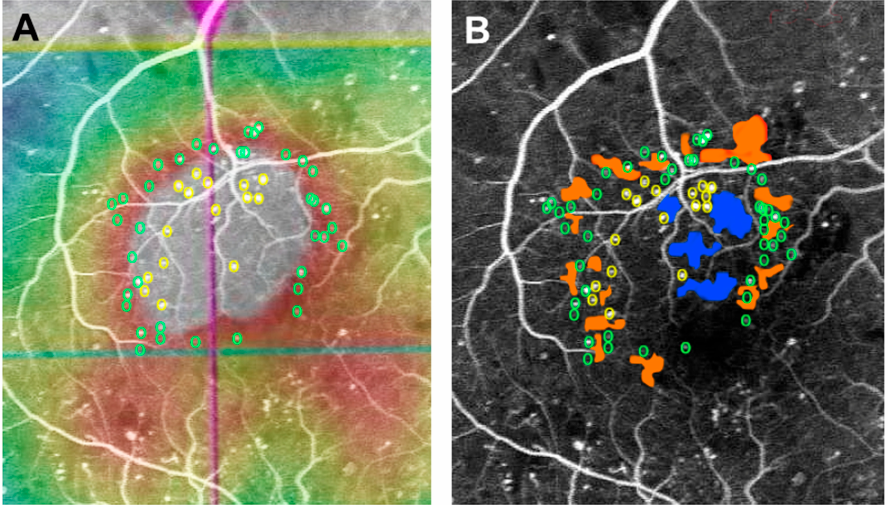
Figure 2. Marking of microaneurysms and capillary dropouts in a merged image. ( A ) Distribution of microaneurysms (MAs) in the center (yellow circle) and periphery (green circle) of diabetic macular edema (DME). ( B ) Distribution of the capillary dropouts (CDOs) in the center (blue area) and periphery (orange area) of DME.